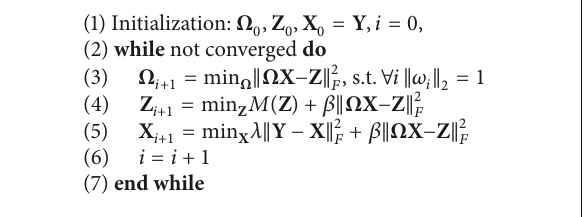
Algorithm 1: Analysis dictionary learning algorithm